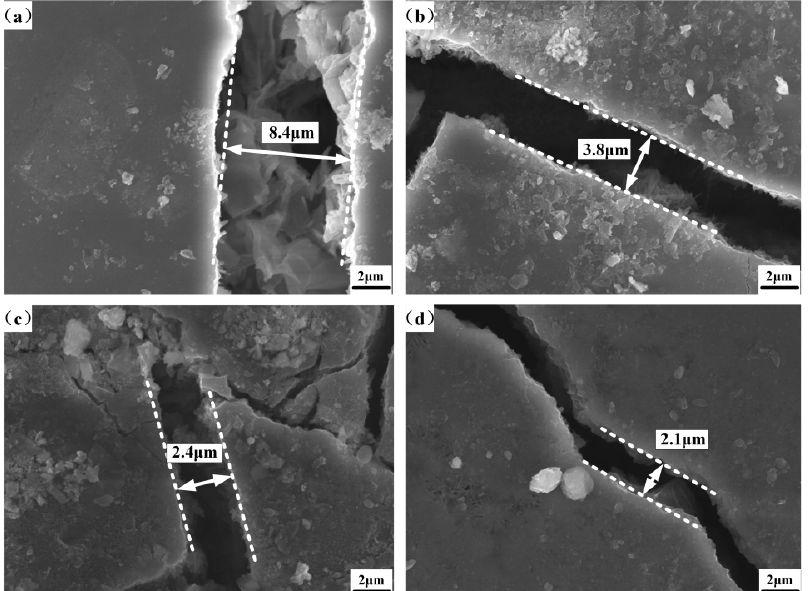
Figure 9. Corrosion crack morphology of each sample; ( a ) the corrosion crack morphology of Sample polished; ( b ) the corrosion crack morphology of Sample USP; ( c ) the corrosion crack morphology of Sample DUSGP; ( d ) the corrosion crack morphology of Sample WUSGP.